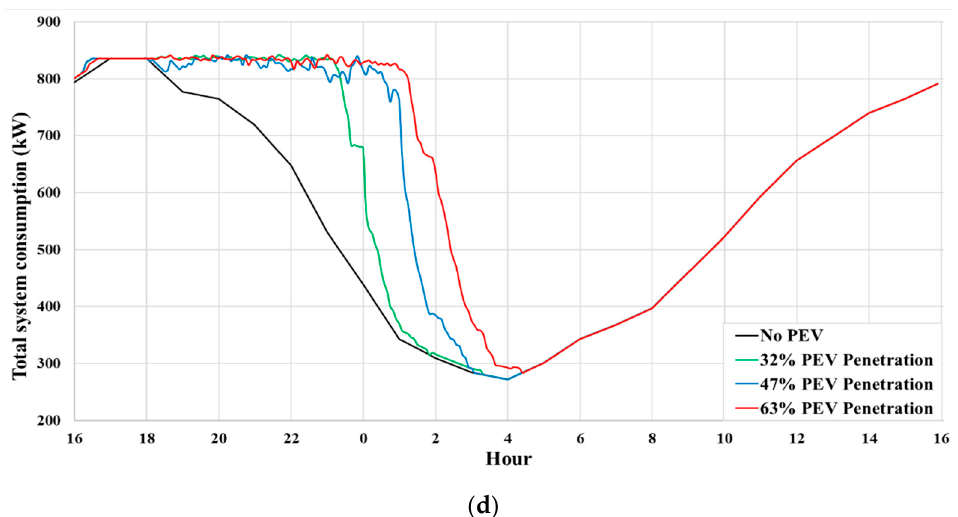
Figure 6. Total system power loss using ( a ) BPSO and ( b ) BGWO, and total power consumption using ( c ) BPSO and ( d ) BGWO with capacitor switching and OLTC adjustment during PEV charging coordination.